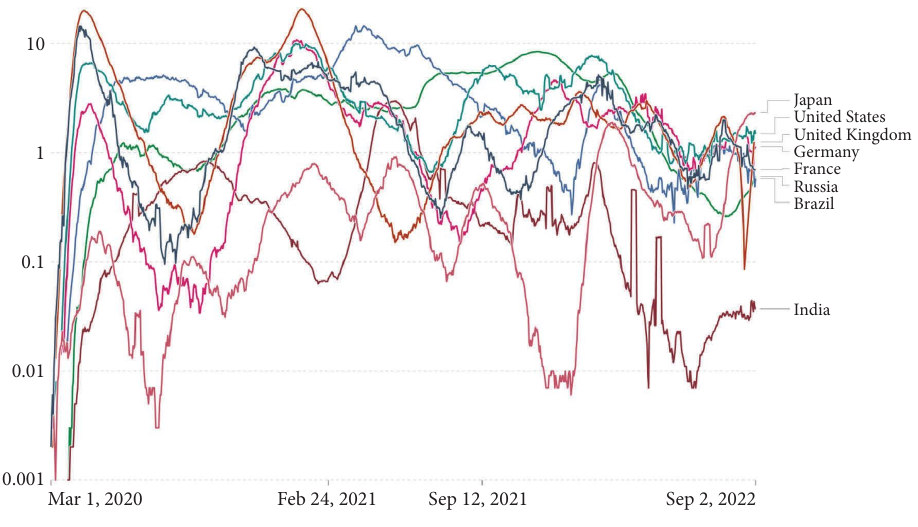
Figure 1: Daily new confrmed COVID-19 cases per million